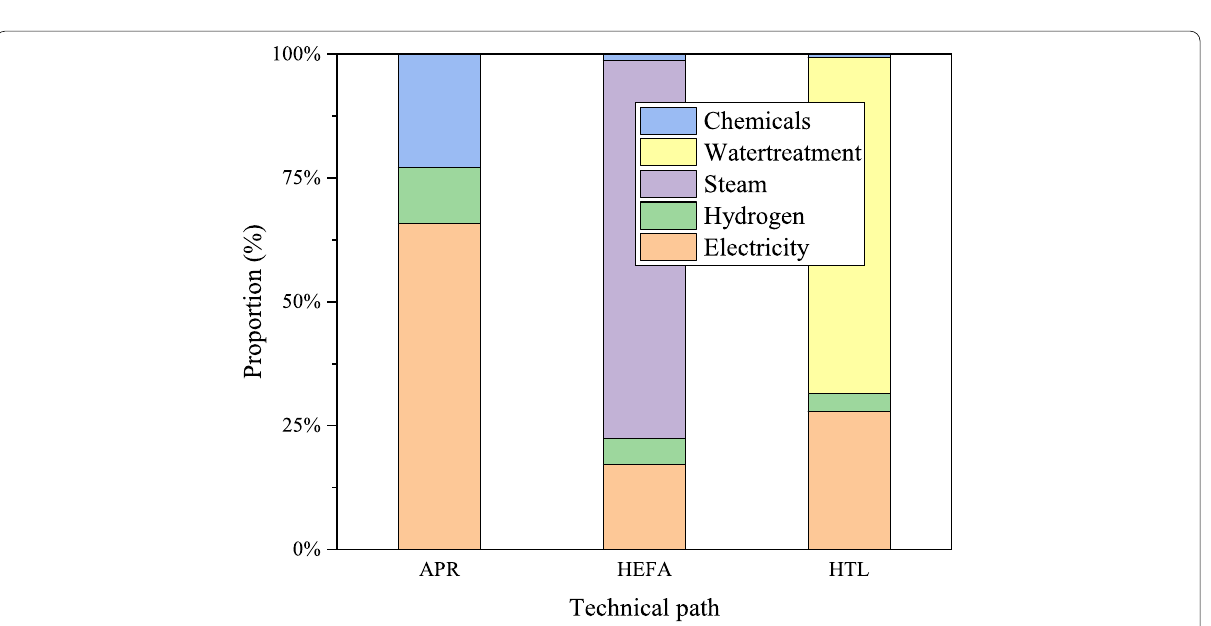
Fig. 7 GWP structures of the conversion process of three